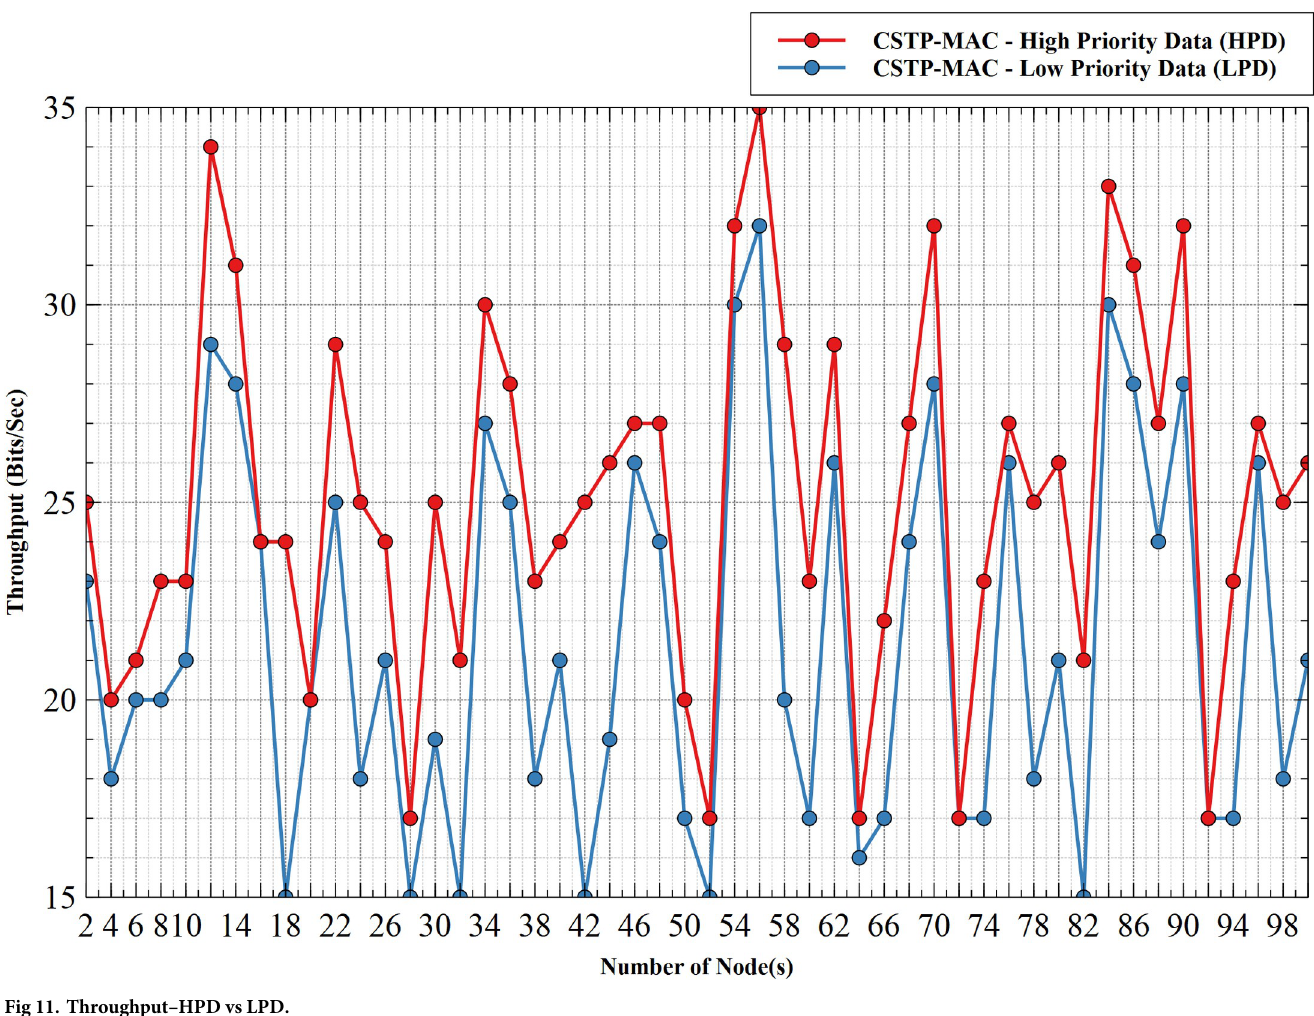
Fig 11. Throughput–HPD vs